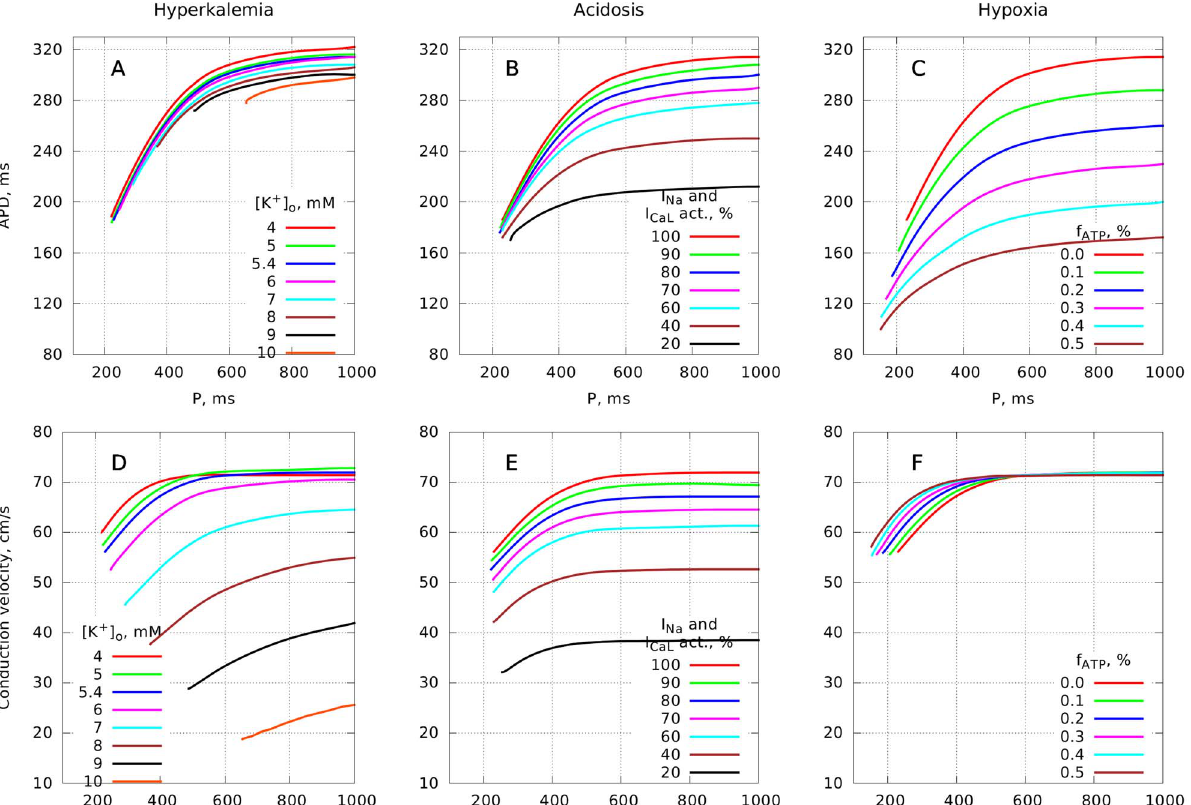
Figure 2. A, B, C: APD restitution curves for hyperkalemia, acidosis and hypoxia respectively. D, E, F: CV dispersion relations for hyperkalemia, acidosis and hypoxia respectively. P denotes the sum of diastolic interval (DI) and APD at the point of measurement for the pulse generated by the S2 stimulus.